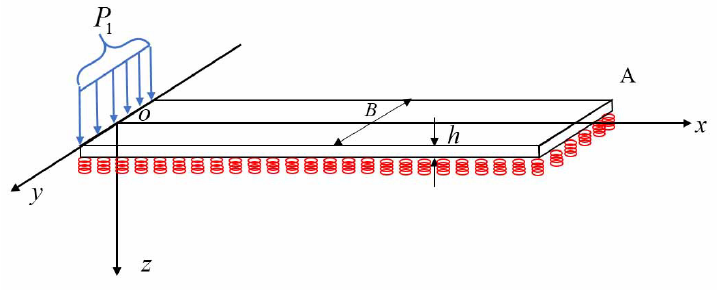
Figure 4. Semi-infinite elastic plate resting on an elastic foundation.